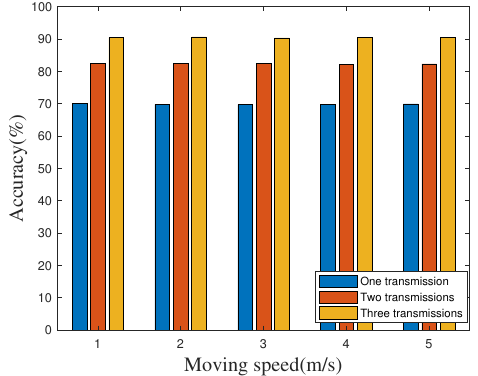
Figure 12. Effect of unmanned aerial vehicle (UAV) moving